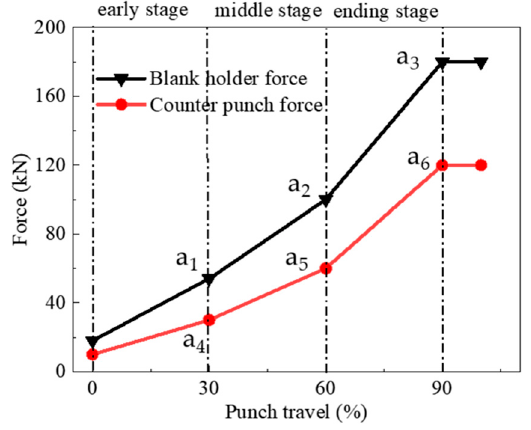
Figure 8. Schematic diagram of forming force variation loading.